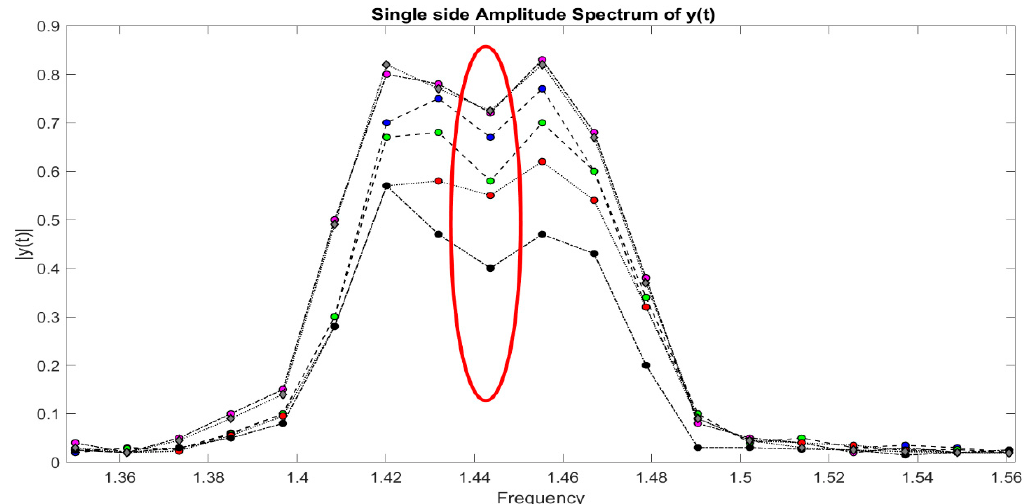
Figure 11. Detected leaks from 1 to 6: magnitude vs. frequency.